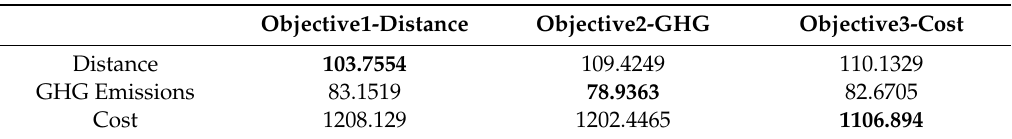
Table 11. Running results with different objectives.